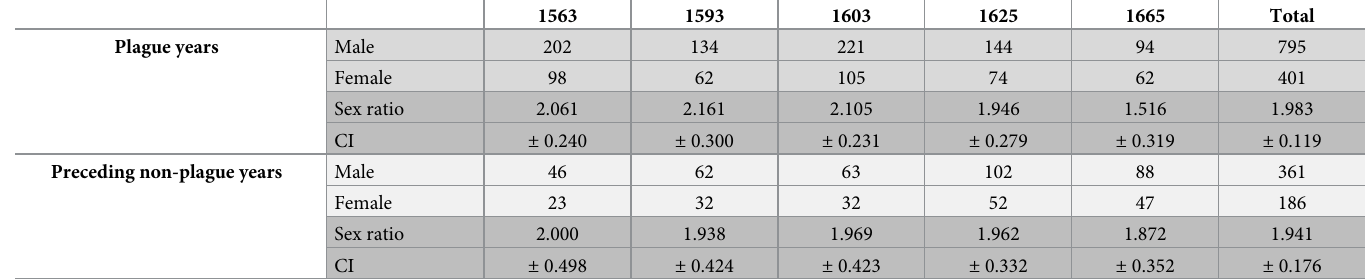
Table 3. Servants: A comparison between the frequency of male and female burials for the plague years under study and the preceding, non-plague, five-year peri- ods. The combined totals are also presented.